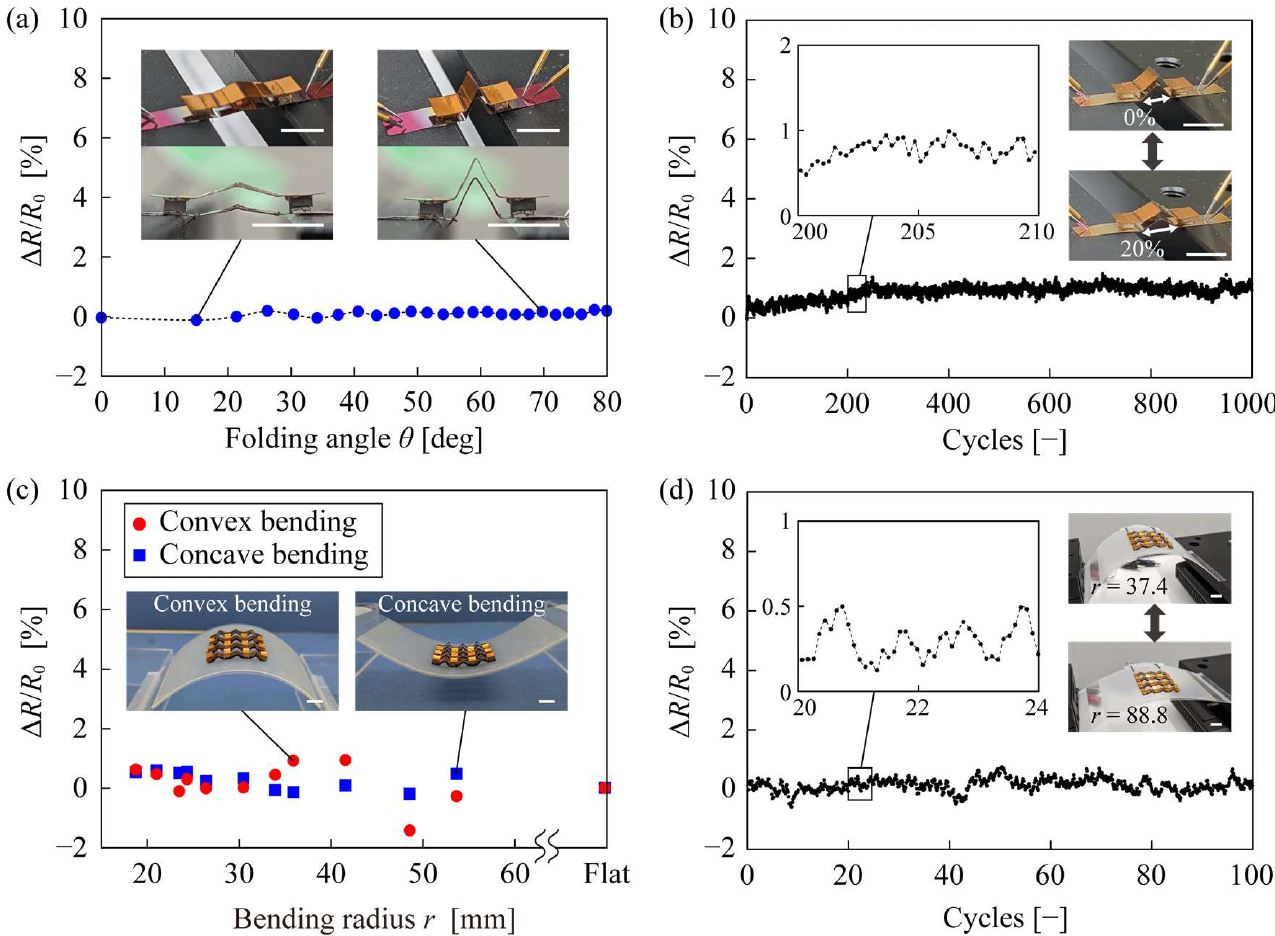
Figure 5. Evaluation of deformation resistance. ( a ) Resistance change when the folding angle is changed. ( b ) Cycle test with repeated stretching deformation at 20% strain. ( c ) Resistance change when bent in convex and concave directions. ( d ) Cycle test with repeated bending deformation. The scale bar was 5 mm.